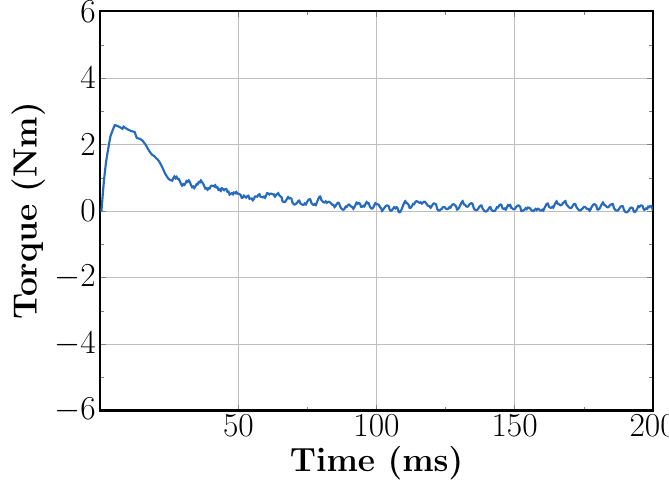
Figure 28. Sensorless speed control for 100 RPM, synchronous motor’s generated